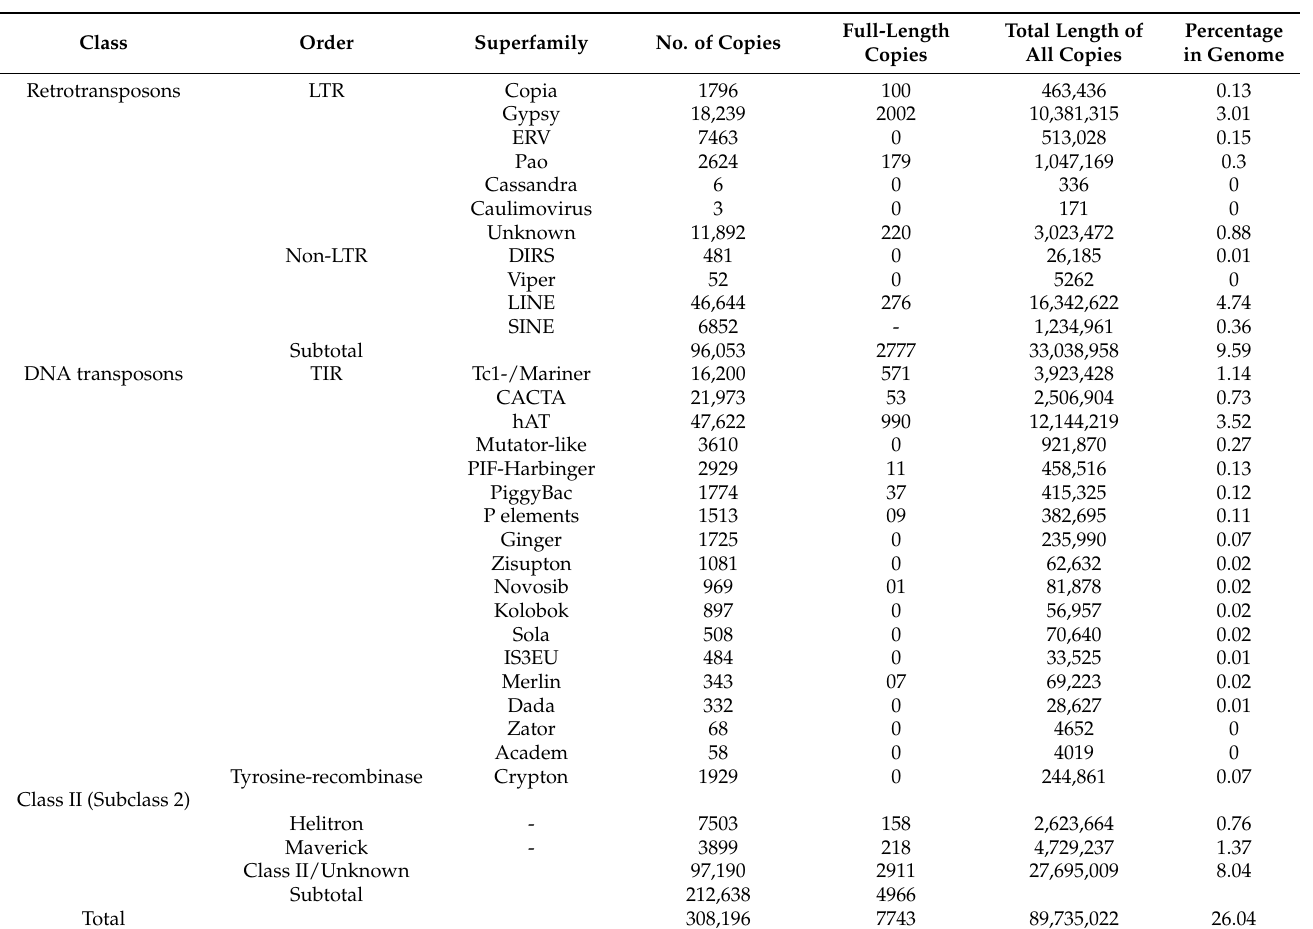
Table 1. Classification and proportion of transposable elements identified in the genome of Schlecht- endalia chinensis